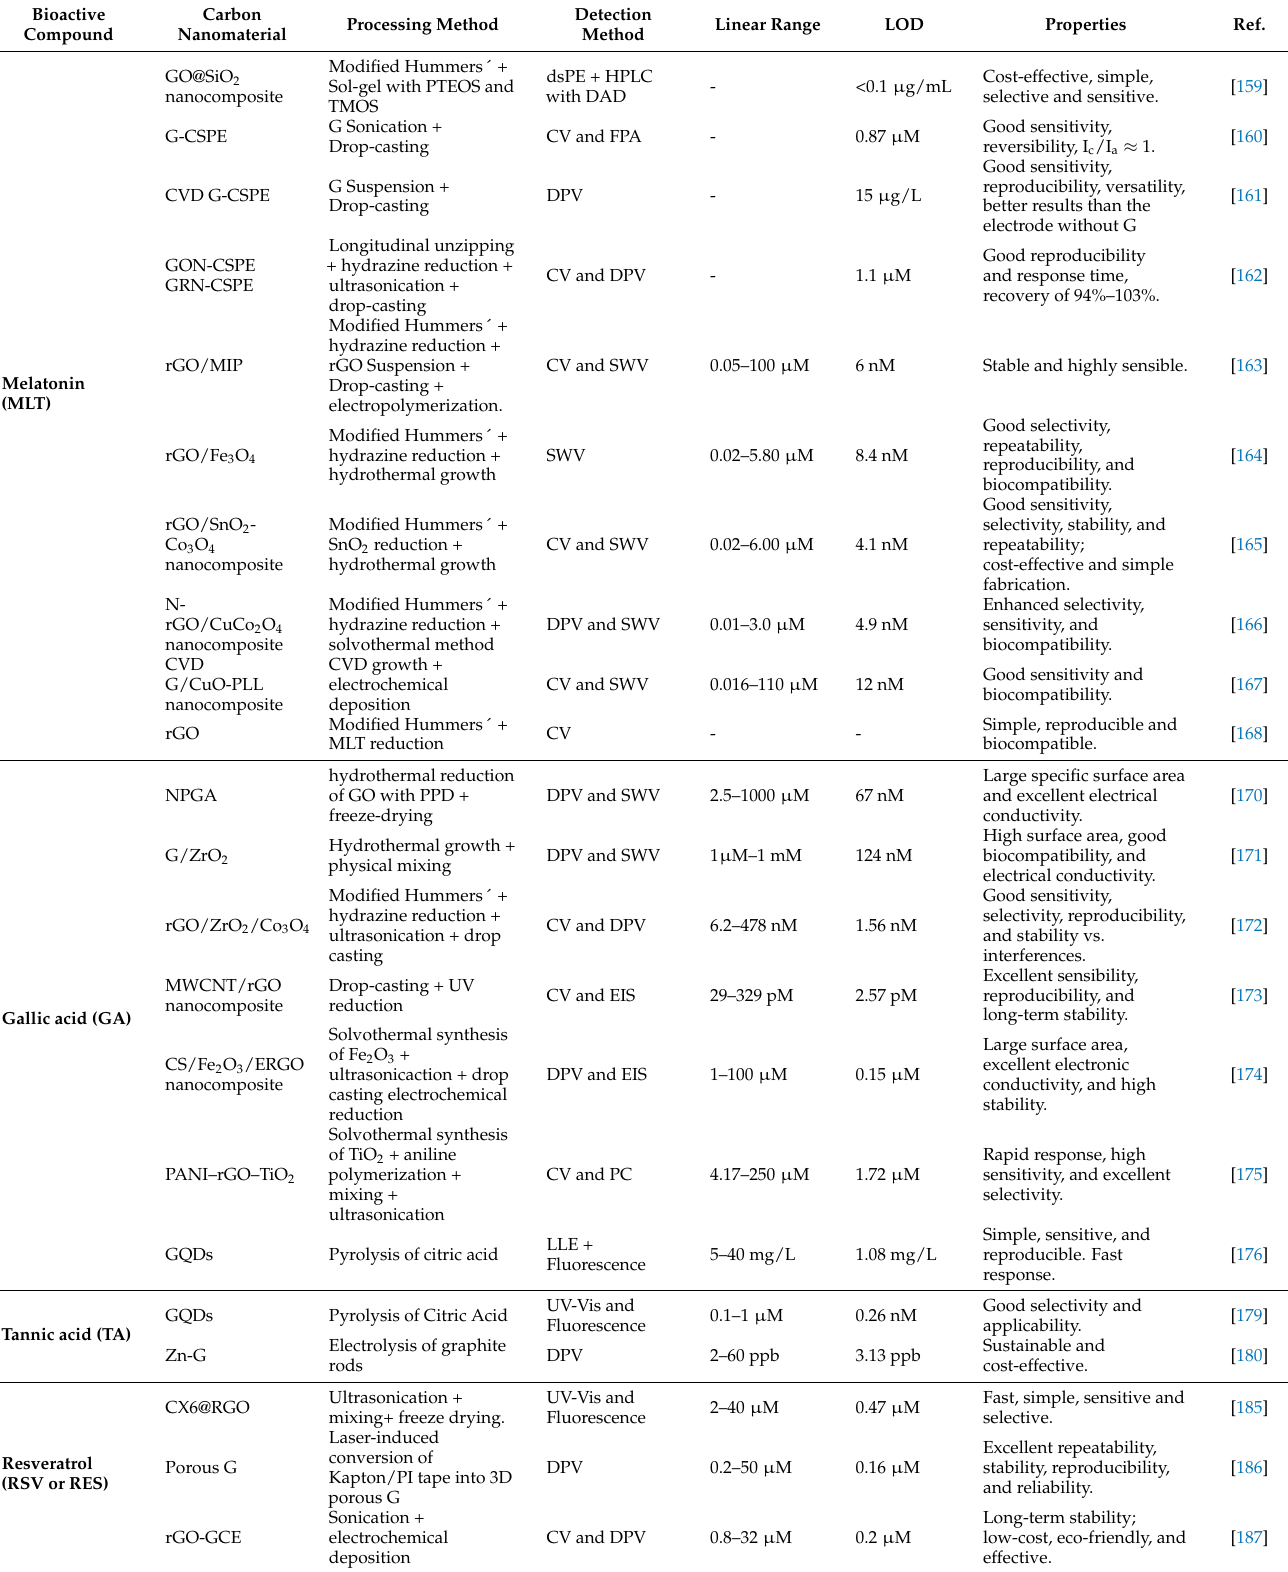
Table 2. Characteristics of graphene-based sensors for the detection of bioactive compounds. Bioactive